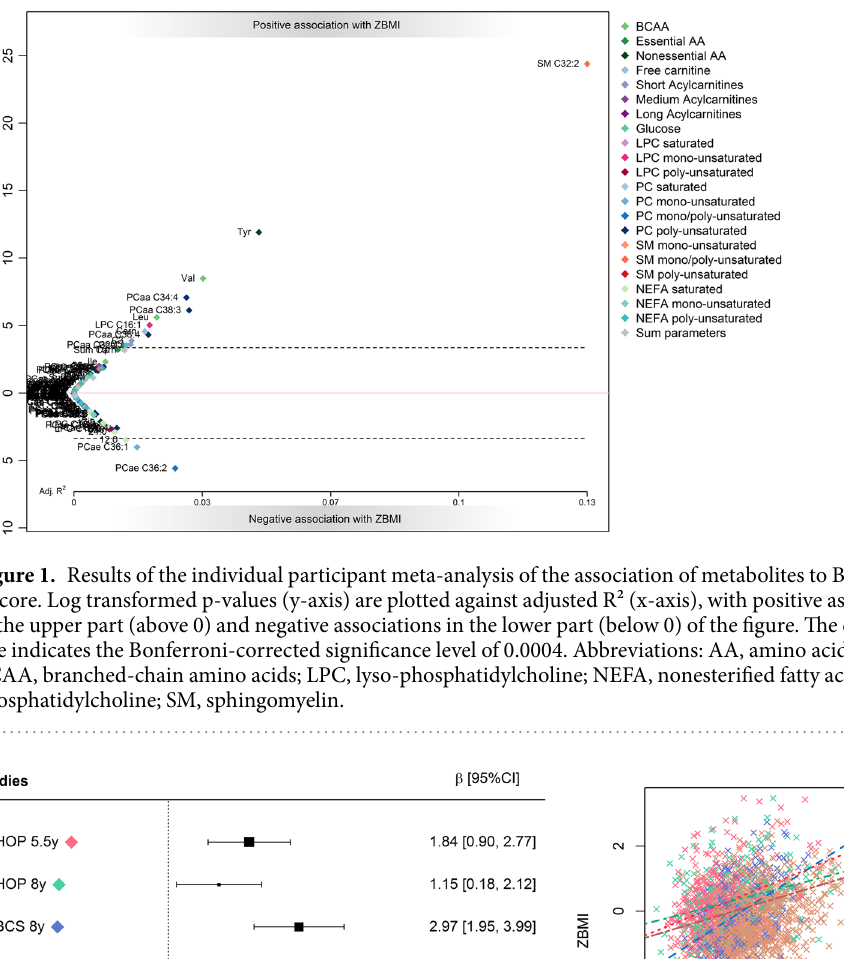
Carn 12:1 (R 2 = 0.03, P = 1.94 × 10 − 10 ) and 14:1 (R 2 = 0.04, P = 3.53 × 10 − 13 ) as well as NEFA 16:0 (R 2 = 0.03, P = 1.73 × 10 − 11 ) and 20:4 (R 2 = 0.04, P = 2.62 × 10 − 13 ) showing the strongest associations. Adjustment for BMI z-score did not alter the associations between HOMA levels and metabolites in the meta-analysis (Supplemental Fig. 1). In the separate analysis of the four populations, we identified 68 metabolites as significantly associated with HOMA index in one or more populations, 13 of them positively and 55 negatively related to HOMA index (Supplemental Table 5). Carn 14:1 was negatively associated with HOMA-index in all four populations. Among the metabolites negatively related to HOMA in two studies were eleven NEFA species, acetylcarnitine, Carn 4:0. OH, 12:0, 12:1, 16:0, and 18:1. Among the metabolites positively related to HOMA in two studies were alanine, tyrosine, H1 and free carnitine. All three associations were detected in CHOP 8 years and UBCS 8 years. Associations with Lipoproteins.